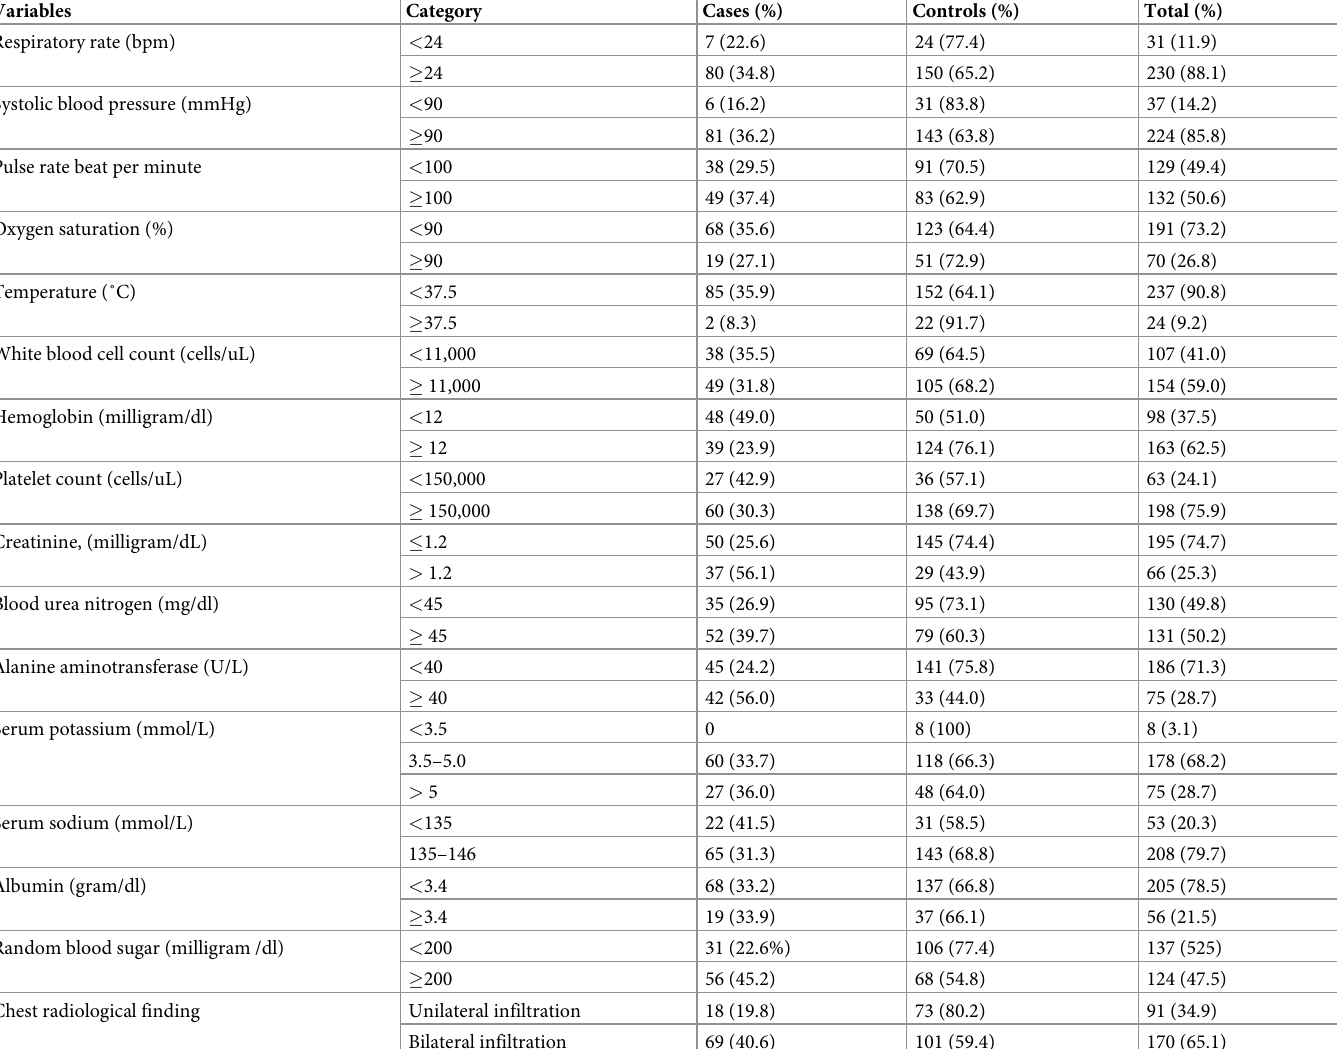
Table 3. Baseline vital sign parameters and laboratory finding between early mortality and late mortality among COVID-19 patients at Addis Ababa COVID care centers, Ethiopia, 2022 (n =